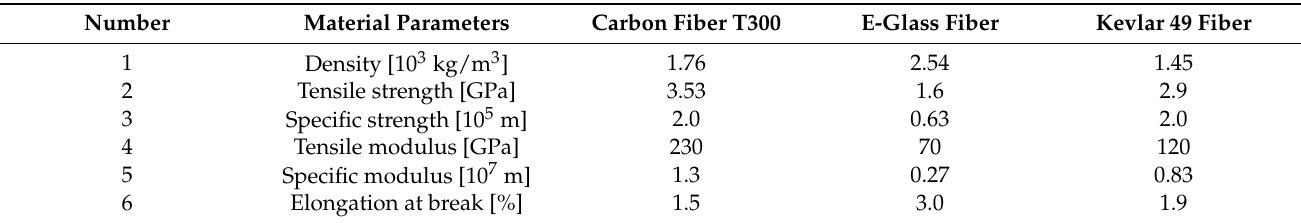
Table 1. Performance parameters of typical reinforced